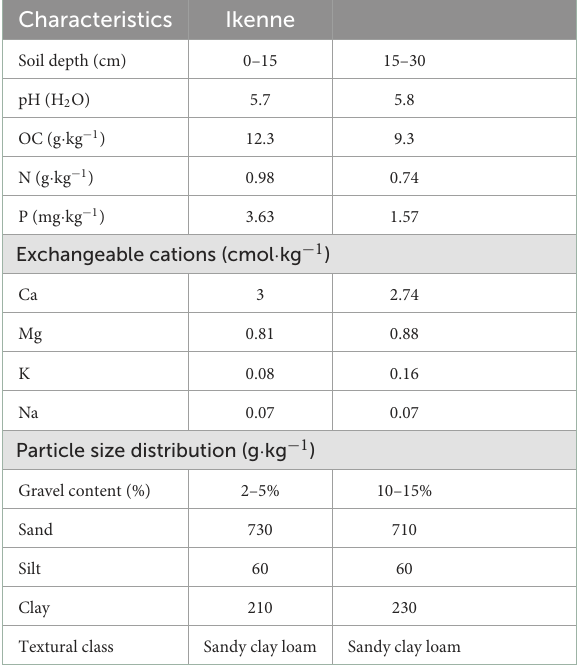
TABLE 1 Physicochemical characteristics of the soil at the Ikenne experimental site.